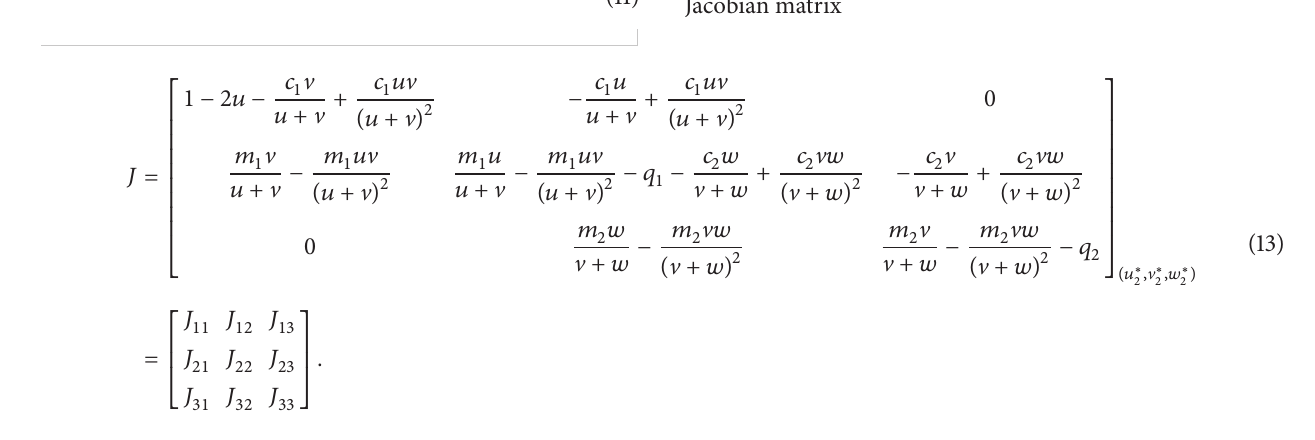
where the diffusion matrix 𝐷 = diag (𝑑 1 , 𝑑 2 , 𝑑 3 ) , and 𝐽